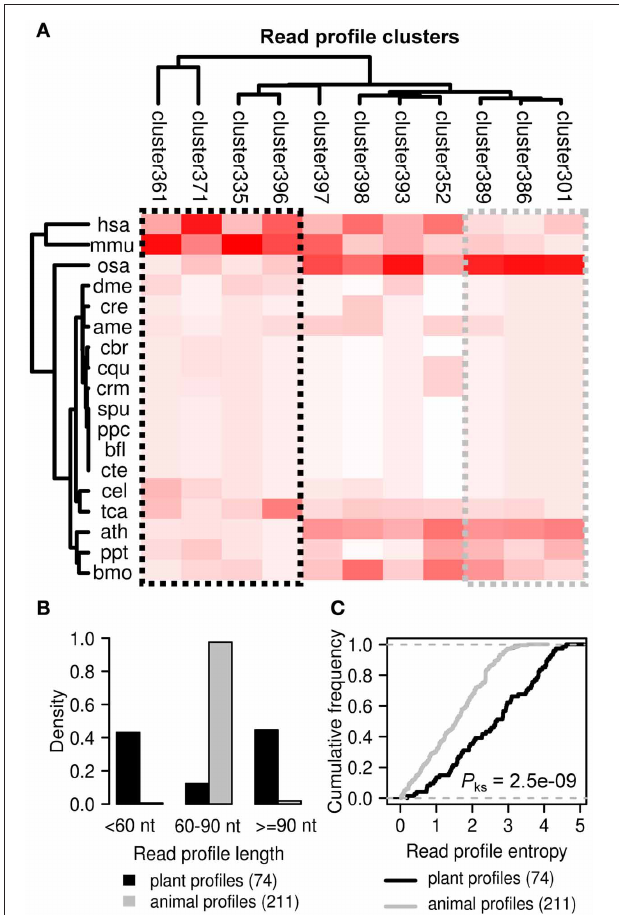
FIGURE 8 | Distinct clusters of read profiles observed for animals and plants. (A) Four clusters of read profiles (black box) are mostly observed in H. sapiens and M. musculus (animal specific). In contrast, three clusters (gray box) are mostly observed in O. sativa and A. thaliana (plant specific). (B) While almost all of the animal specific read profiles are of 60–90 nucleotides in length, plant specific read profiles were either short ( < 60 nt) or long ( ≥ 90 nt) in length. (C) Plant specific read profiles were also observed to have a significantly higher entropy in comparison to those from animals ( p -value < 0.05, Kolmogorov–Smirnovtest). This observation may be attributed to the different biogenesis mechanism of miRNAs in plants and animals (Lelandais-Briere et al.,